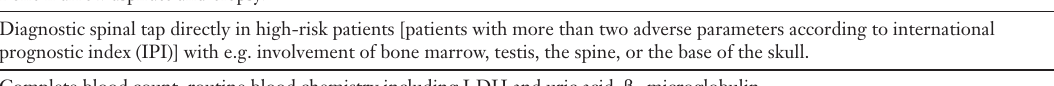
Staging and risk assessment.